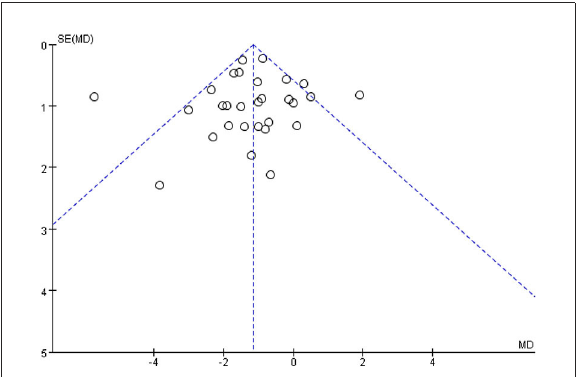
FIGURE5 The publication bias of all studies was determined by funnel